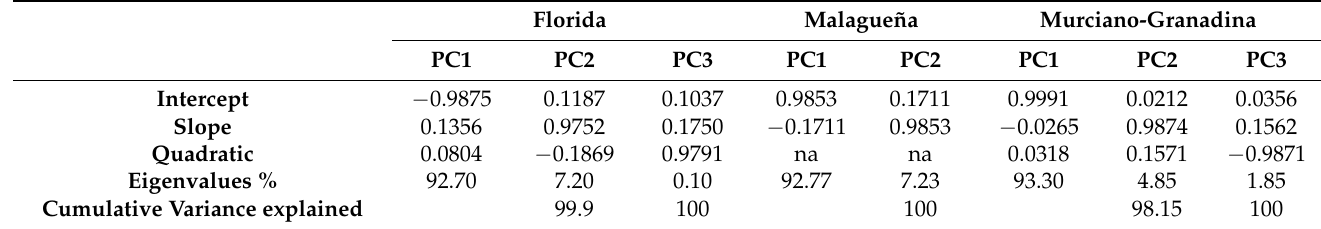
Table 4. Elements of the genetic random regression model 2; eigenvalues and eigenvector coefficients for the first three Principal Components (PC) from Ka matrix (Model 2) for daily fat protein yield in the three Spanish goat breeds studied.